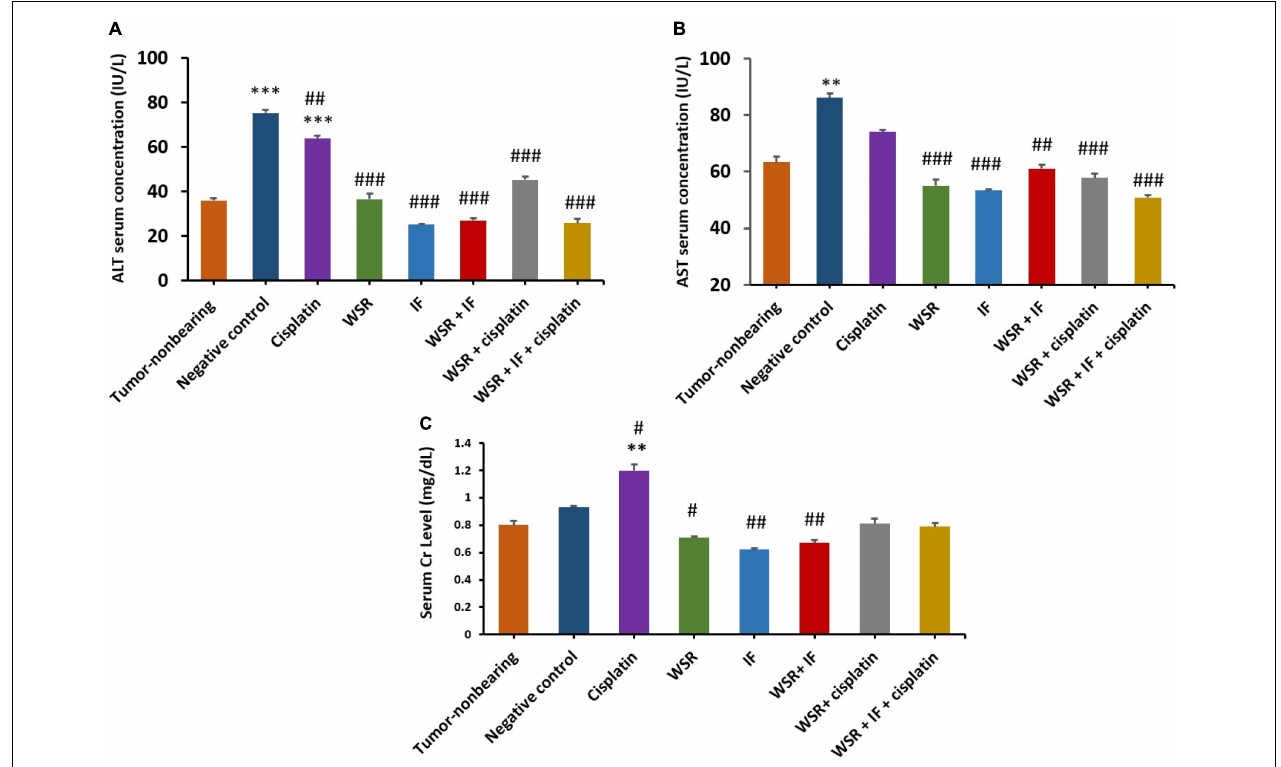
FIGURE 9 | Safety profile for the treatments [WSR extract (100 mg/kg/d), cisplatin (5 mg/kg/week), IF, their combinations]. (A) Serum alanine aminotransferase (ALT) level measured by (IU/L). (B) Serum aspartate aminotransferase (AST) level measured by (IU/L). (C) Serum creatinine level measured by (mg/dl). Results are expressed as means µ SEM ( n = 3). ∗∗ P = 0.001, ∗∗∗ P < 0.001. # P < 0.05, ## P = 0.001, ### P < 0.001. ( ∗ : treatments group compared with the tumor-non-bearing group, # : treatments groups compared to the negative